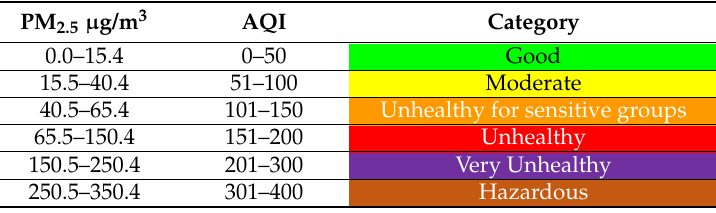
Table 1. Air Quality Index (AQI) levels and category for calculating PM 2.5 subindex adapted from the Environmental Protection Agency (EPA 1999). Each color conforms to a given